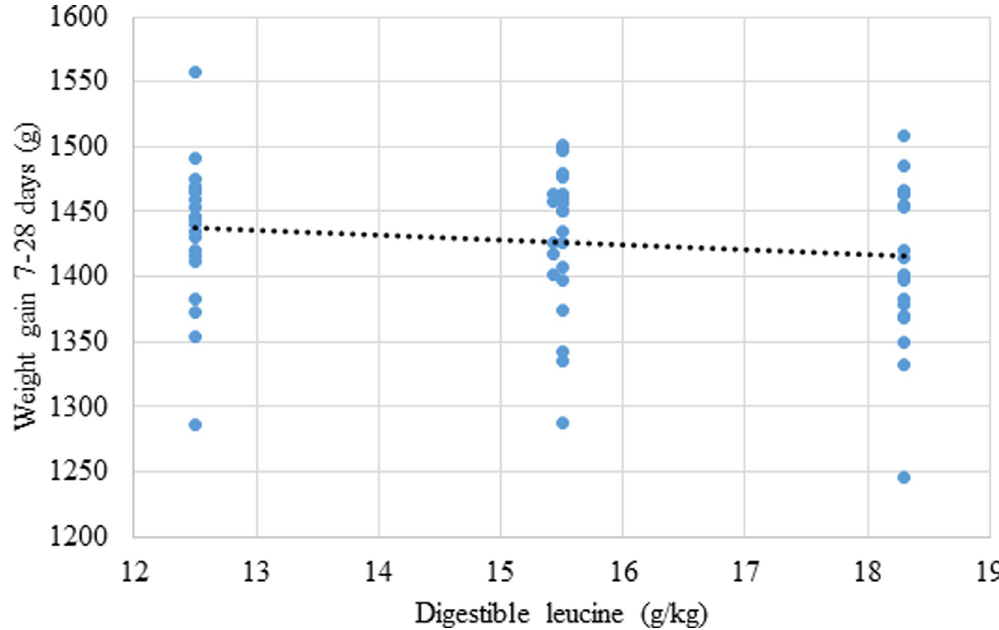
Fig 1. Linear relationship (P = 0.022; r = -0.284) between dietary leucine concentrations and weight gain where: Weight gain (g, 7-28d) = 1487–3.905 × digestible leucine (g/kg ). https://doi.org/10.1371/journal.pone.0266080.g001 relative to lysine where the predicted minimum FCR of 1.418 corresponded to a dietary digest- ible leucine concentration of 14.99 g/kg as shown in Fig 2. Also, relative fat pad weights decreased linearly (P = 0.022; r = − 0.284) with increasing dietary isoleucine (Fig 3). Polynomial regression analysis for quadratic and cross-product differences (P < 0.05) based on lack of fit (P > 0.005) were generated for weight gain, FCR, relative fat pad weights,